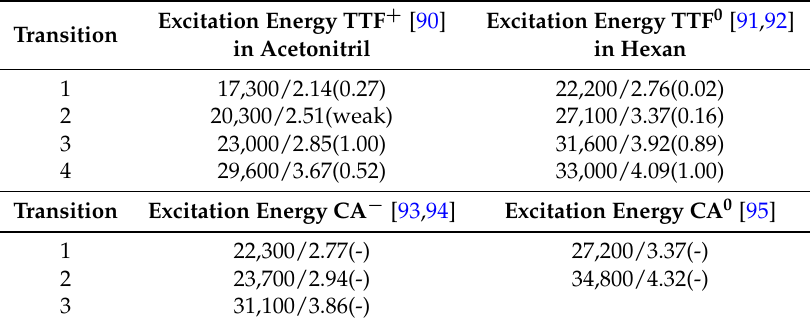
Table 3. Electronic transitions of TTF + , TTF 0 , CA − , and CA 0 correlated with the corresponding experimentally determined excitation energy in wavenumbers (cm − 1 ) and photon energy (eV). The relative intensities are put in